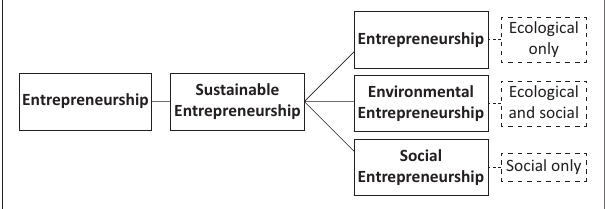
FIGURE 1: Type hierarchy of